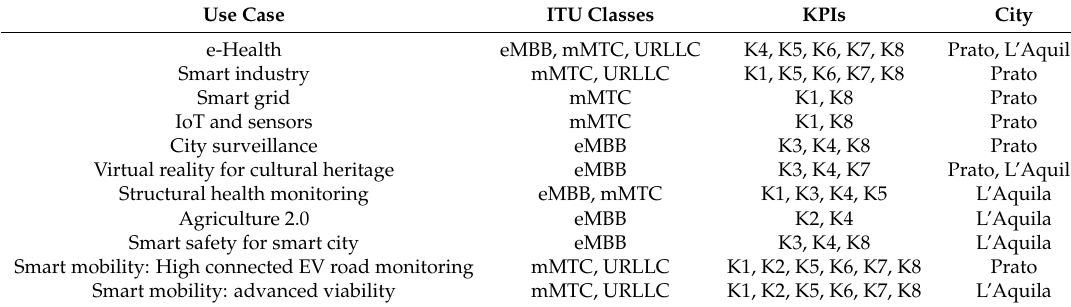
Table 2. Use cases in Prato and